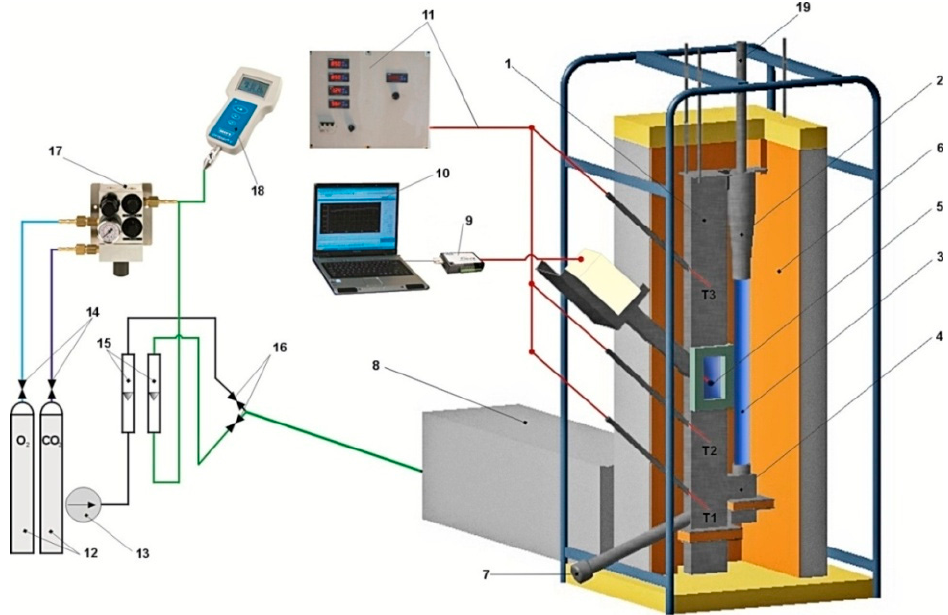
Figure 5. Diagram of a stand with a circulating fluidized bed for combusting solid fuels: 1—fluidization column, 2—cyclone, 3—downpipe, 4—return system, 5—combustion chamber, 6—insulation, 7—drain pipe, 8—air heater, 9—measurement card, 10—computer, 11—measurement system and temperature control, 12—cylinders with technical gases, 13—compressor, 14—pressure reducers, 15—rotameters, 16—control valves, 17—gas mixer, 18—oxygen analyser, 19—exhaust extractor.